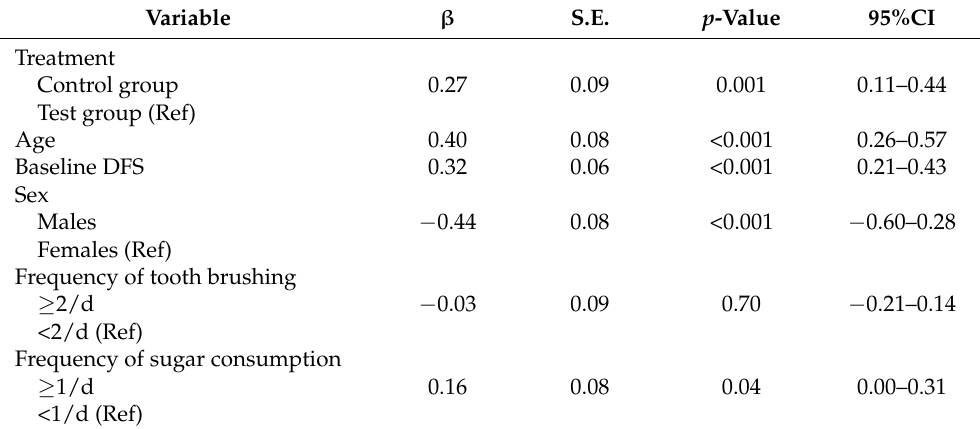
Table 3. Adjusted (generalized linear model) model for decayed and filled surface increments of